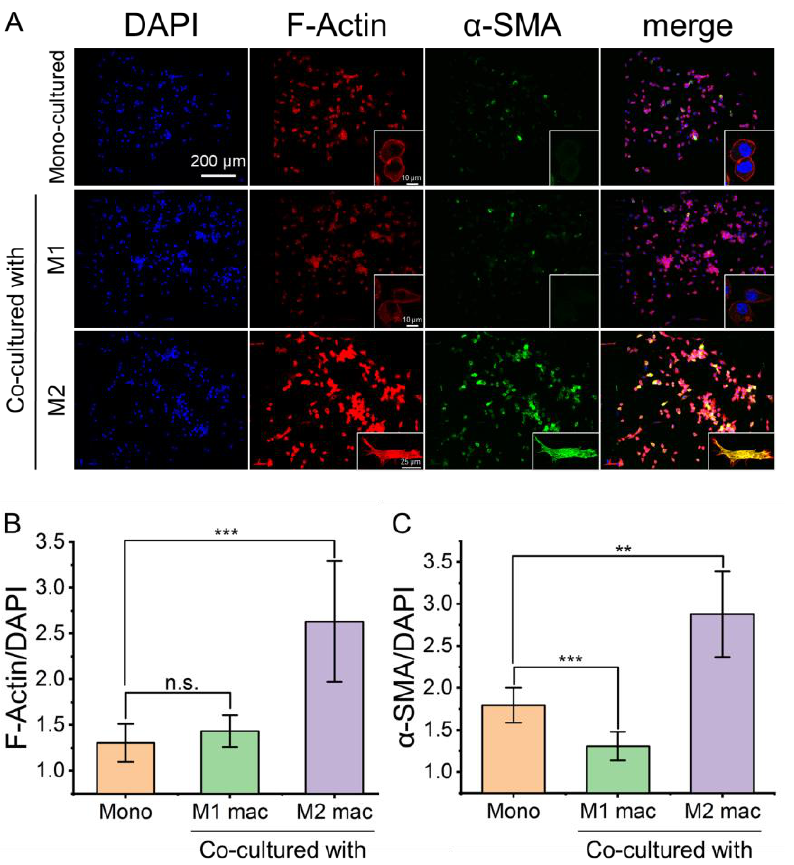
Figure 5. Fluorescence images of fibroblasts with stained α -SMA and F-actin to reveal the activation of fibroblasts by co-culture with different macrophages. ( A ) Fluorescence images of fibroblasts stained for F-actin and α -SMA showing differential expression levels under mono- and co-culture conditions. ( B , C ) the ratio of F- Actin/DAPI and α - SMA/DAPI. Herein, “Mono” refers to mono-cultured, “M1 mac” and “M2 mac” refer to “co - cultured with M1 macrophages” and “co -cultured with M2 macrophages”, respectively. Data are presented as mean ± SD (n = 5). “*” is the intragroup comparison with “Mono”. ** p < 0.01; *** p < 0.001.